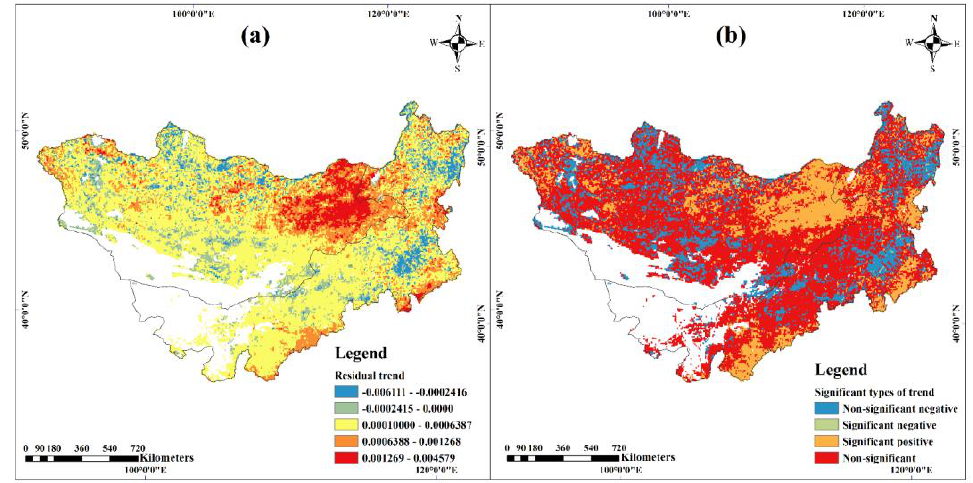
Figure 10. Spatial distribution of the effect of anthropogenic factors on mean growing season normalised difference vegetation index (NDVI) in the Mongolian Plateau using the RESTREND method. ( a ) the residual trend using linear regression method, ( b ) the residual trend at the 95% confidence